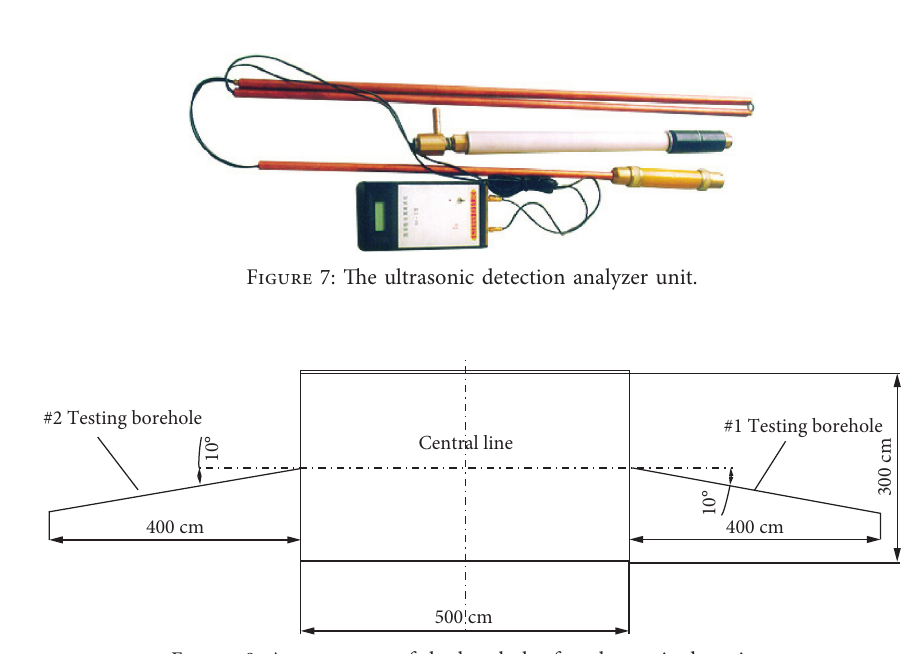
Figure 6: Vertical cross section distribution of the plastic zone in surrounding rock. (a) Drilling field. (b) Roadway.